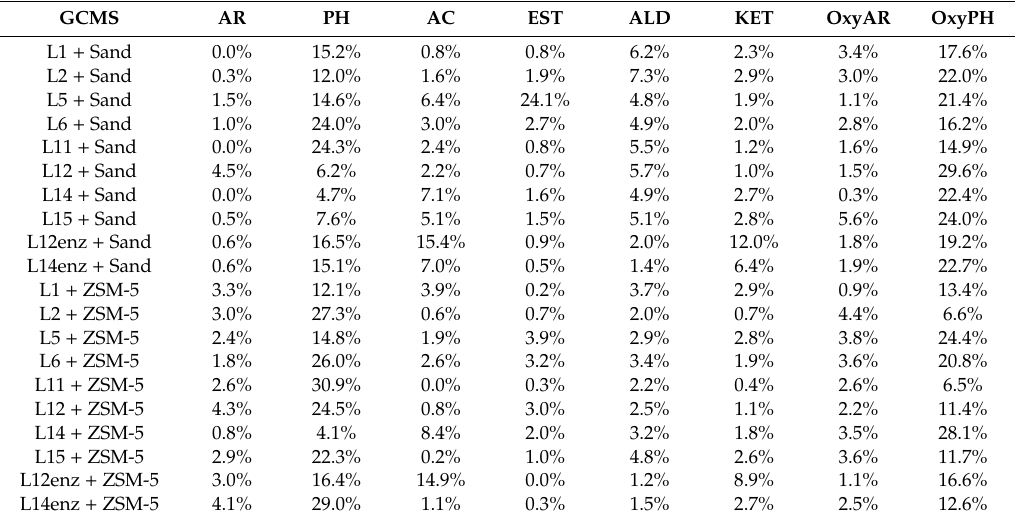
Table 2. GCMS semiquantitative representation of thermal and catalytic pyrolysis of lignin